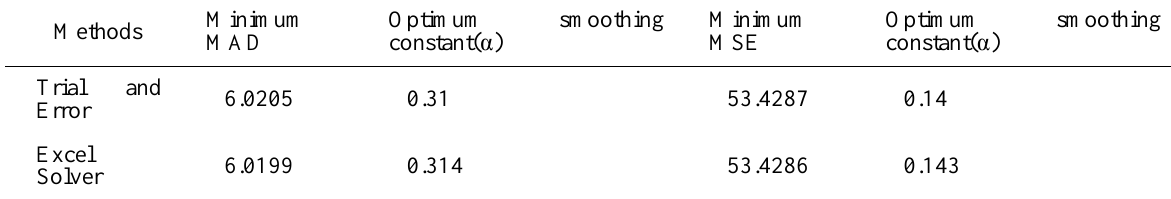
Table 5. Summary of